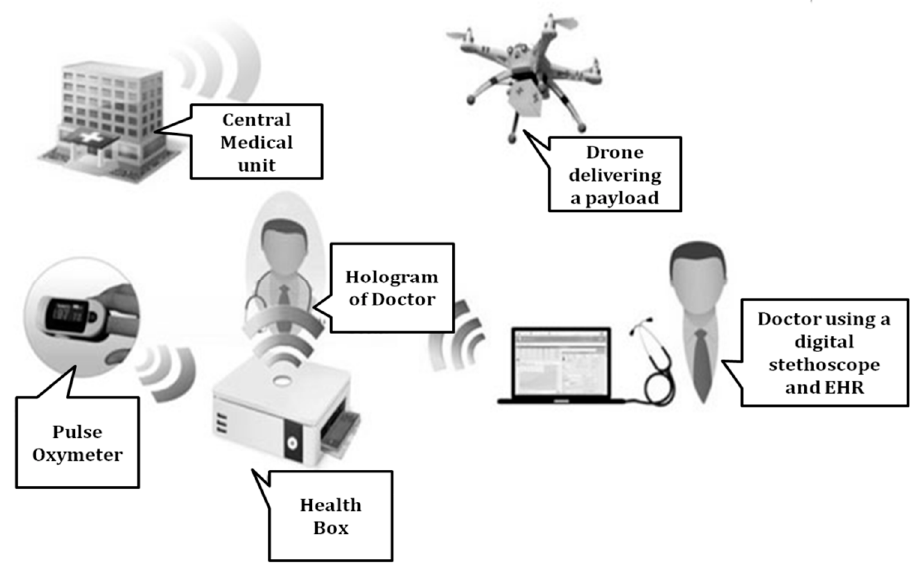
Figure 3. Deployment of drones in healthcare applications.